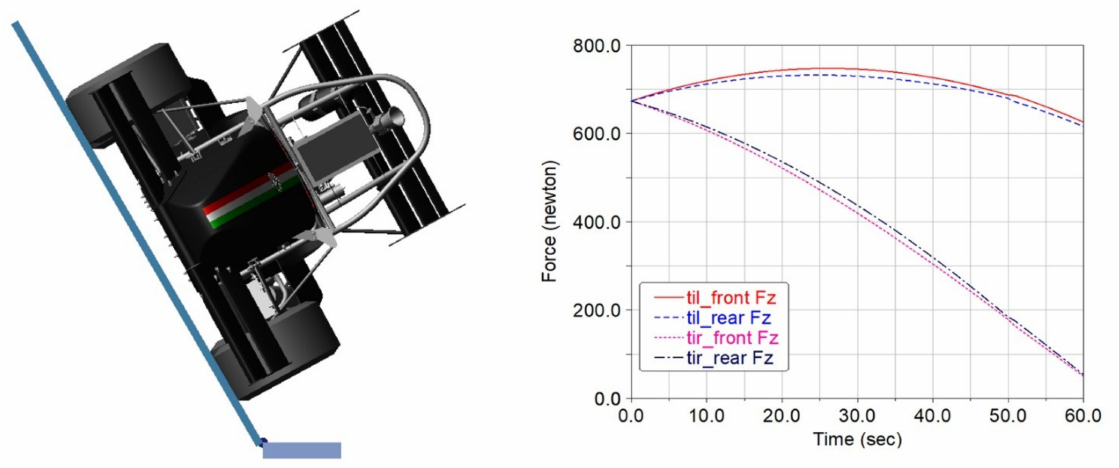
Figure 8. Tilt test—best set-up; til/tir: left/right tire. Please note that since the test is performed at a constant tilt rate of 0.017 rad/s (1 ◦ /s), the labels along the x -axis correspond to the platform tilt angle in degree